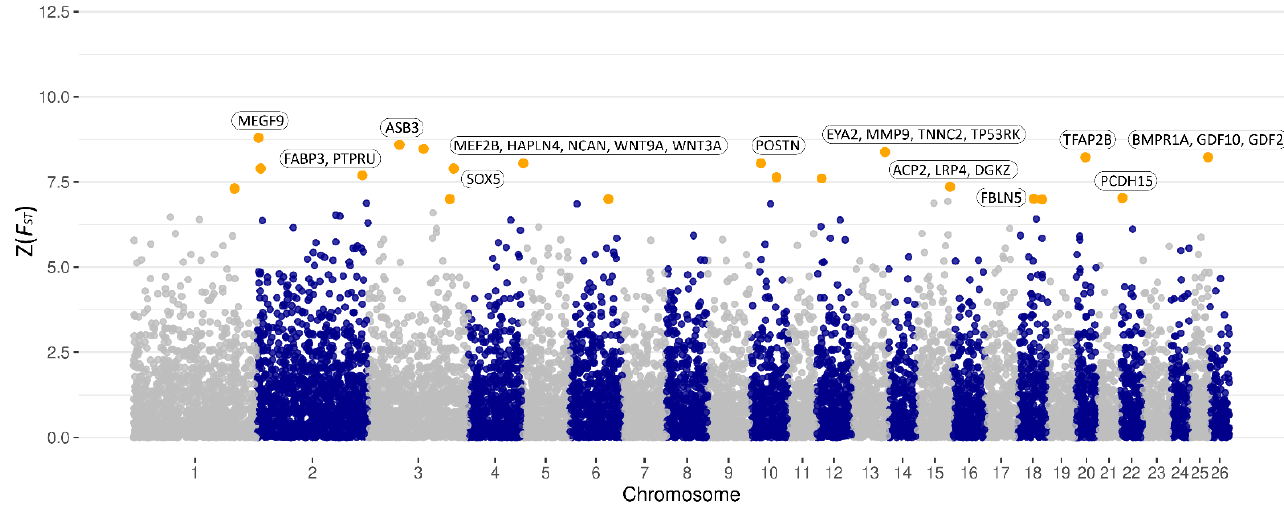
Figure 3. Manhattan plot of the Z( F ST ) values for each single nucleotide polymorphism (SNP) of weaning weight. Orange dots represent SNPs that passed the cutoff threshold at 99.95% of the percentile distribution (Z( F ST ) ≥ 6.99). Table 3. Genomic positions of SNPs that exceeded the cutoff threshold (Z( F ST ) ≥ 6.99) for divergence in weaning weight and adjacent candidate genes within a 2 Mb window.